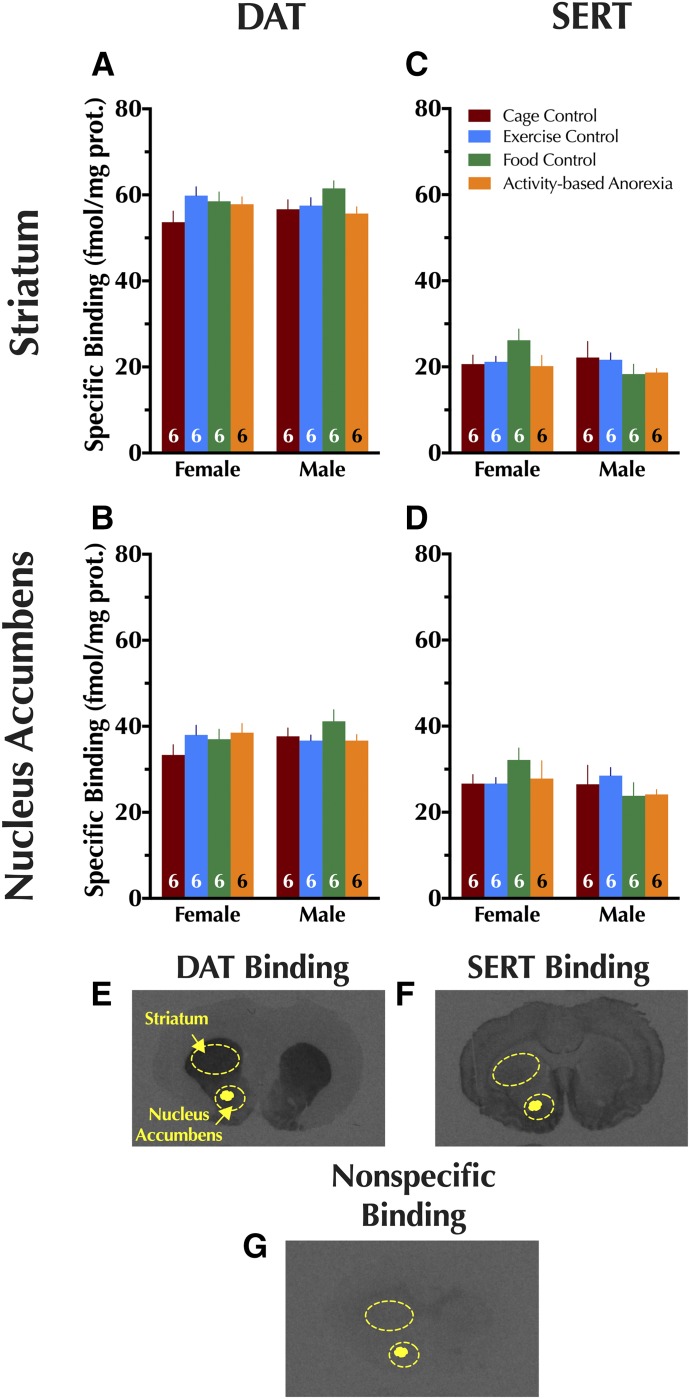
Quantitative autoradiography in adolescents for dopamine and serotonin transporter expression. Specific binding for dopamine transporter is shown in adolescent (A) striatum and (B) nucleus accumbens. Specific binding for serotonin transporter is also shown in adolescent (C) striatum and (D) nucleus accumbens. Representative brain sections illustrating (E) DAT, (F) SERT, and (G) nonspecific binding are shown with the analyzed regions for striatum and nucleus accumbens illustrated with dashed circles. Data were analyzed within each age group with a two-way (sex × condition) ANOVA. Data are graphed as mean + S.E.M. Number of animals is indicated at base of each bar.